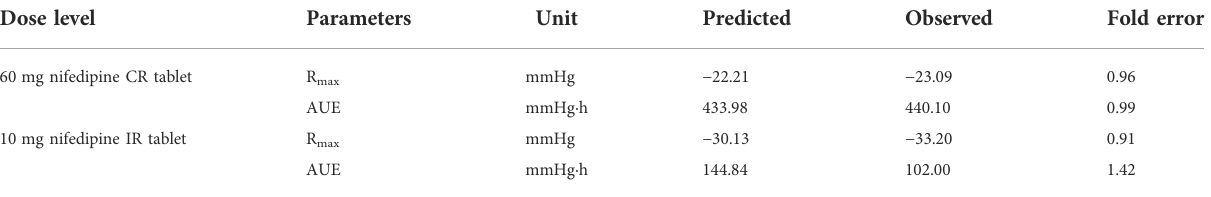
TABLE 5 Comparison of the predicted R max , and AUE to the observations for nifedipine CR tablet and IR